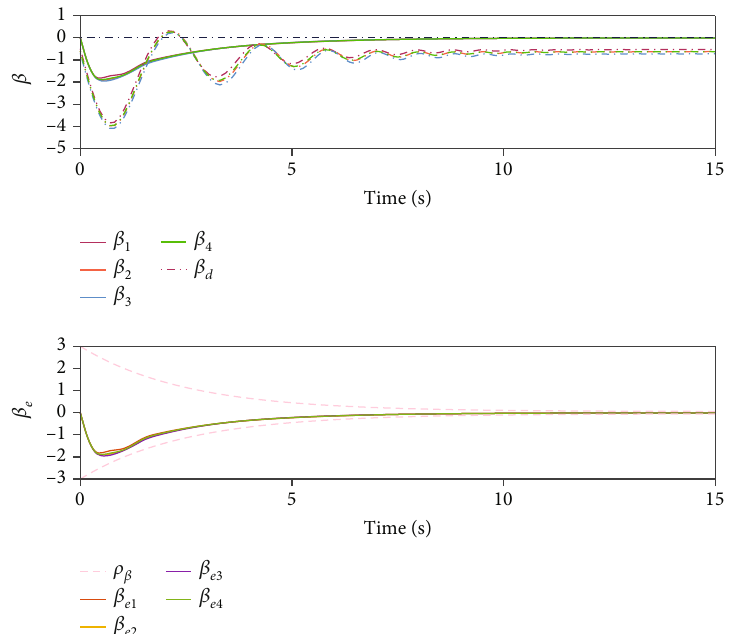
Figure 9: Sideslip angle β .